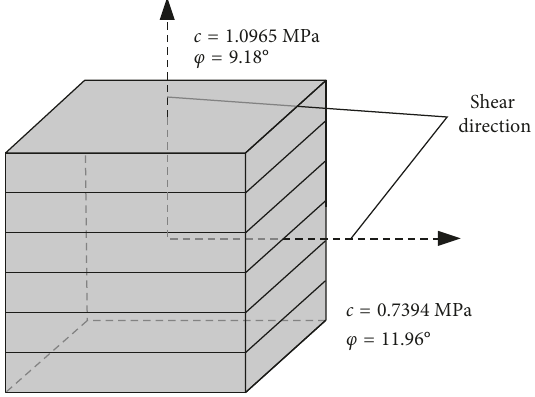
Figure 17: Tunnel dimensions and 3D numerical model mesh shape with bedding plane direction. Table 3: Parameters of rock mass.